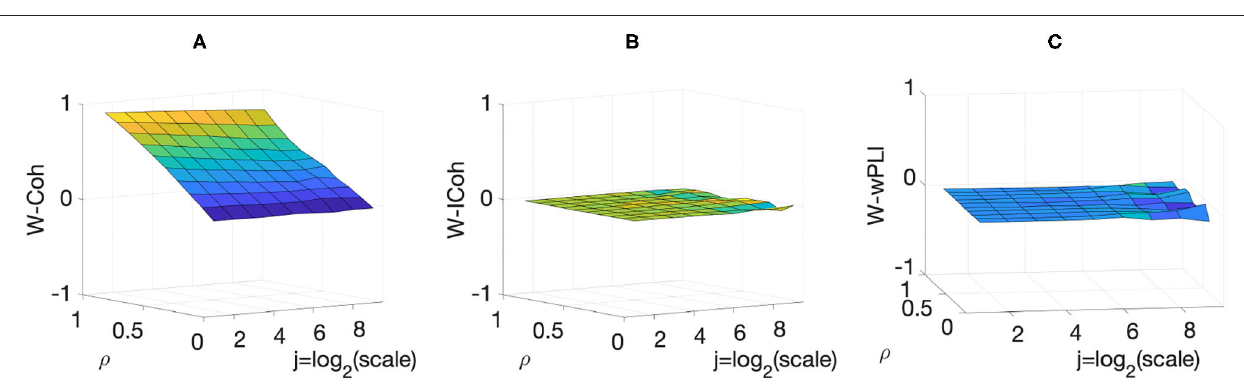
FIGURE 2 | Complex Wavelet-based connectivity on synthetic bivariate fractional Gaussian noise with correlation but no delay. W-COH (A) , W-ICOH (B) , and W-wPLI (C) as function of octaves j and correlation coefficient ρ . As it should, W-COH correctly assesses correlations with no delays and thus departs from 0 at all scales. W-COH would hence lead to incorrectly assessing functional connectivity. In contrast, W-ICOH and W-wPLI show averages values of 0 at all scales and across all correlation levels, thus leading to assess no connectivity, which is as expected for non-delayed